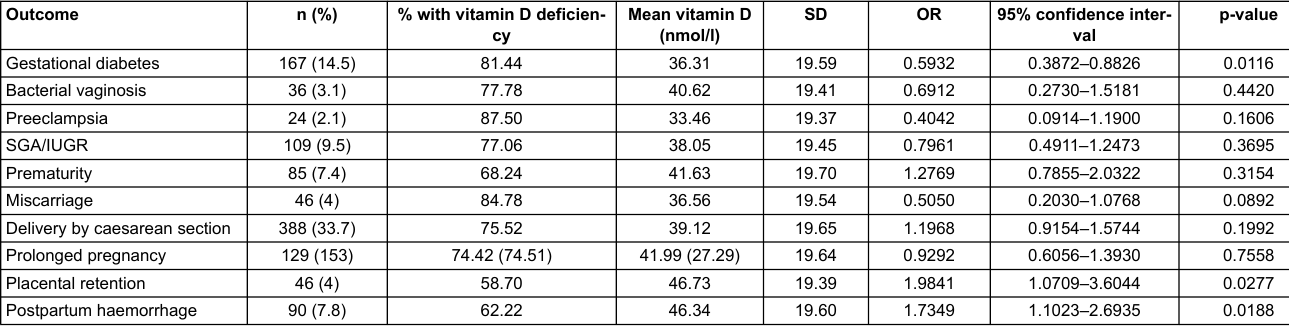
Table 4: Associations between vitamin D status and pregnancy outcomes. Outcome